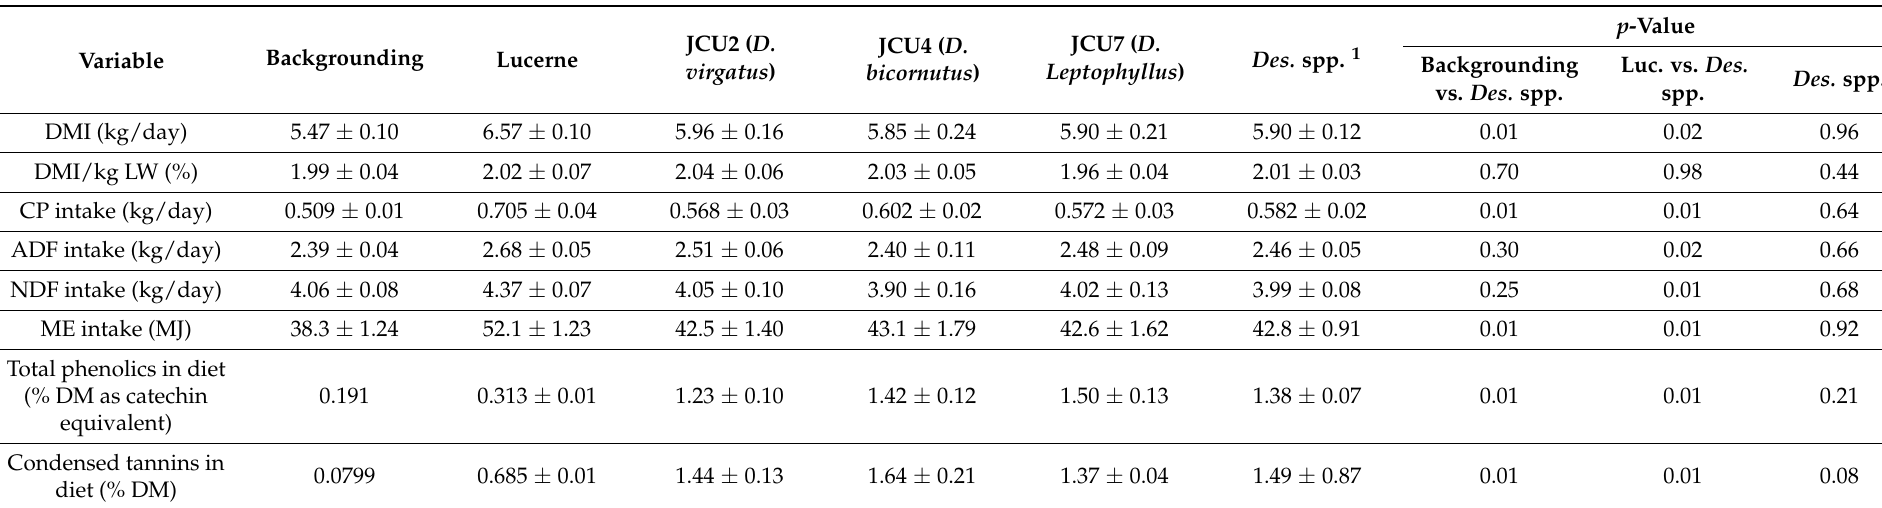
Table 2. Nutrient intakes and phenolic concentrations ( ± SEM) of the backgrounding, lucerne and Desmanthus spp. diets.